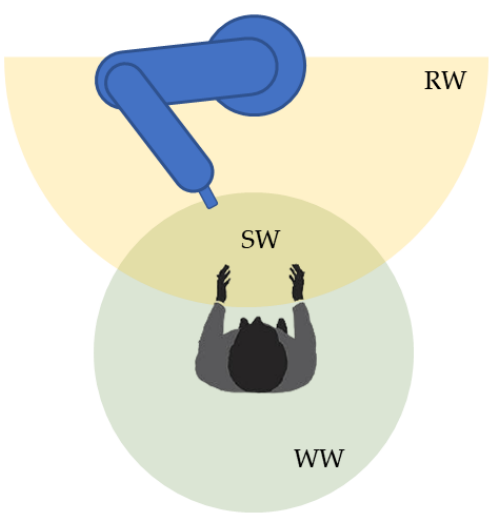
Figure 1. Robots’ and workers’ workspaces.